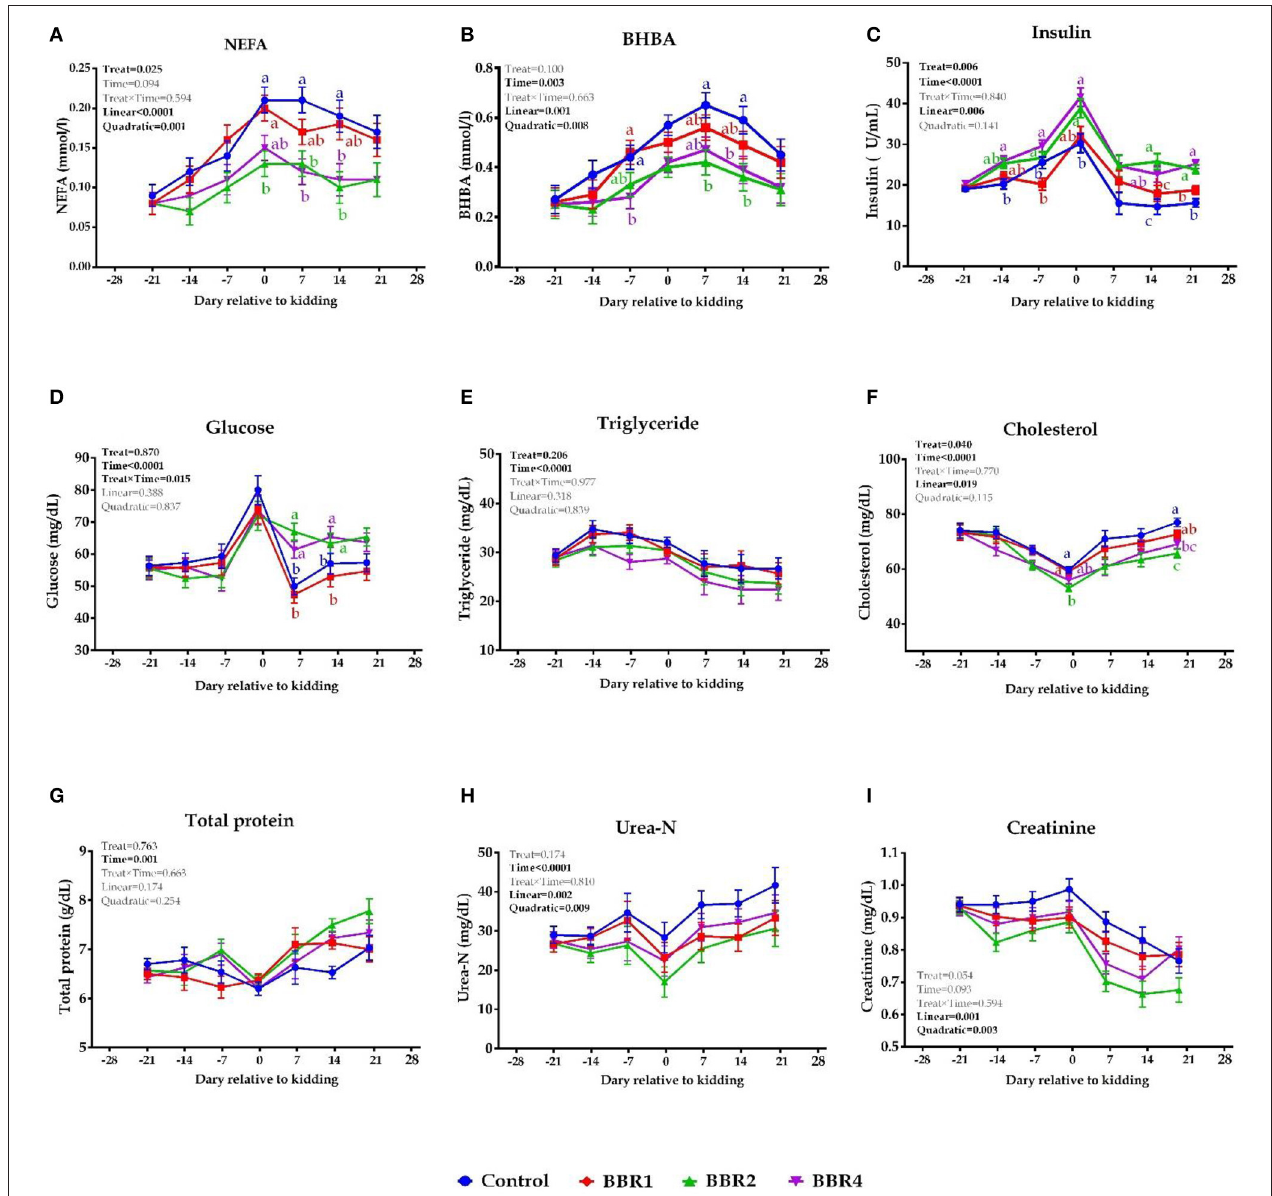
FIGURE 1 | Means ( ± SEM) of (A) NEFA, (B) BHBA, (C) insulin, (D) glucose, (E) triglyceride, (F) cholesterol, (G) total protein, (H) urea-N, and (I) creatinine in Saanen dairy goats supplemented with different levels of BBR during the transition period. a − c Values with different superscript letters at the same time point are significantly different ( P ≤